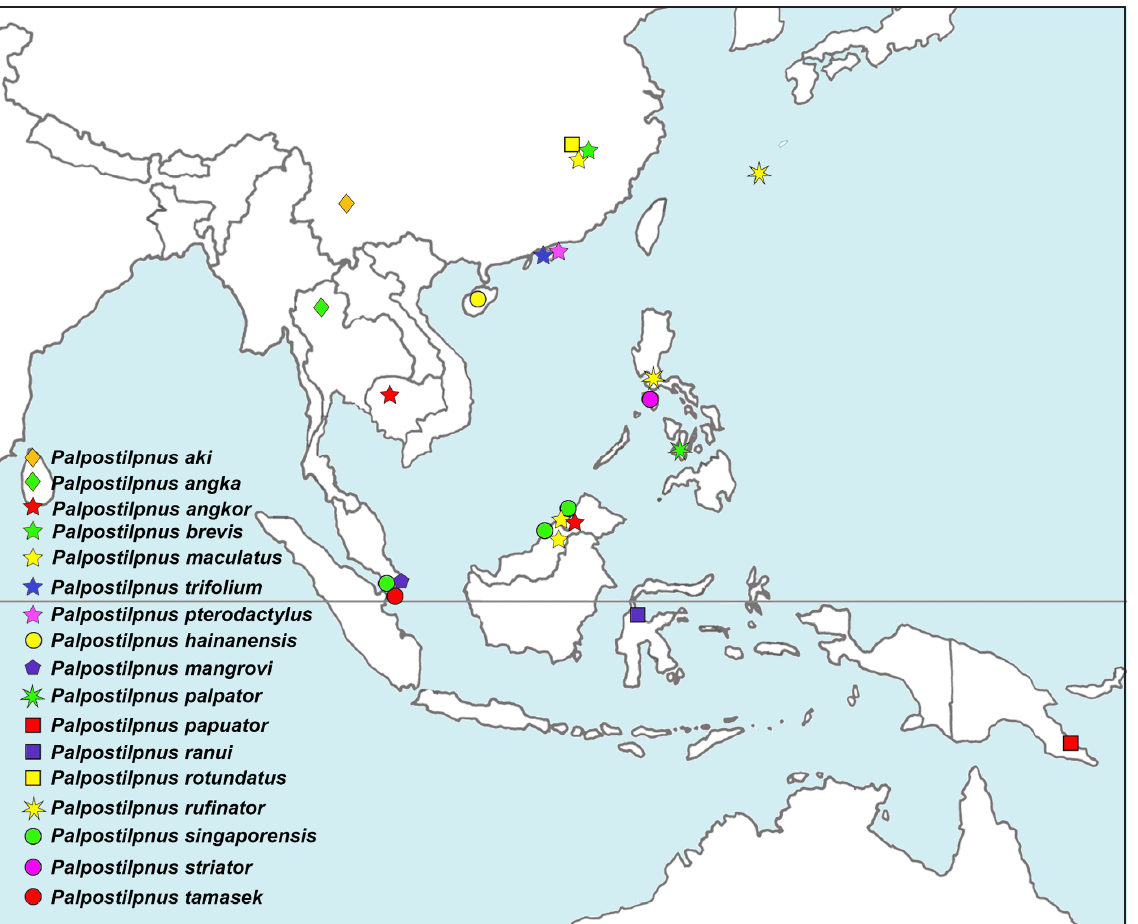
Fig. 1. Distribution of 17 species of Palpostilpnus Aubert,